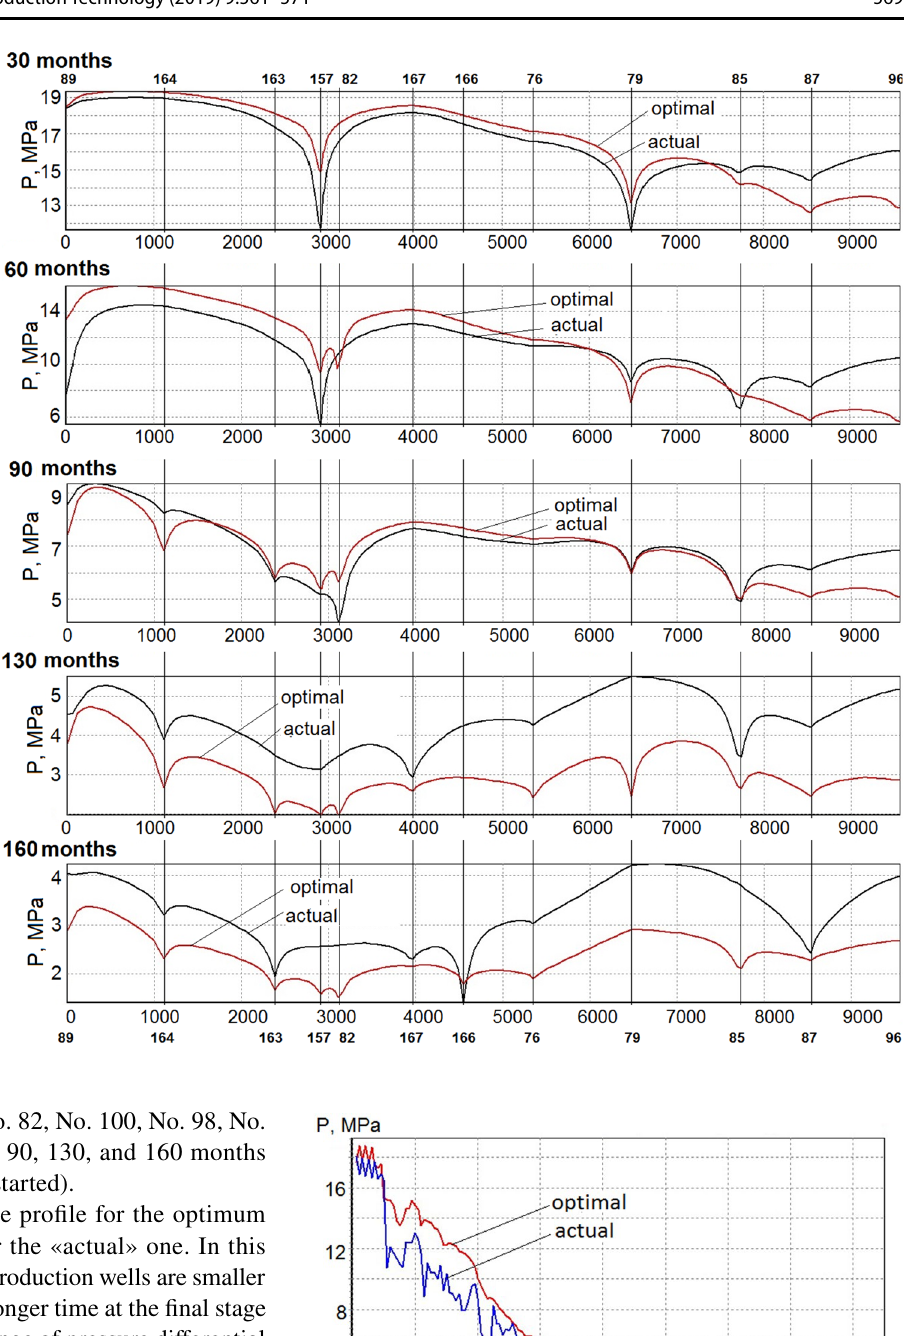
Fig. 6 Pressure profiles at